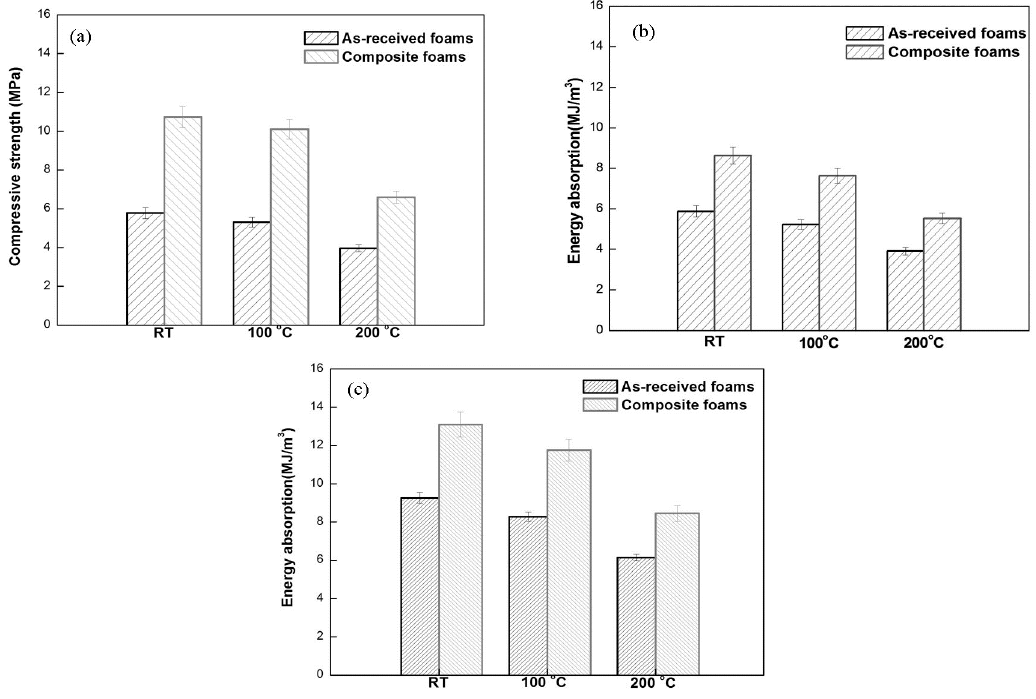
Figure 9. The compressive properties of as-received Al foams and composite foams at different temperatures: ( a ) compressive strength and energy absorption capacities at a strain of ( b ) 0.5 and ( c ) 0.6.